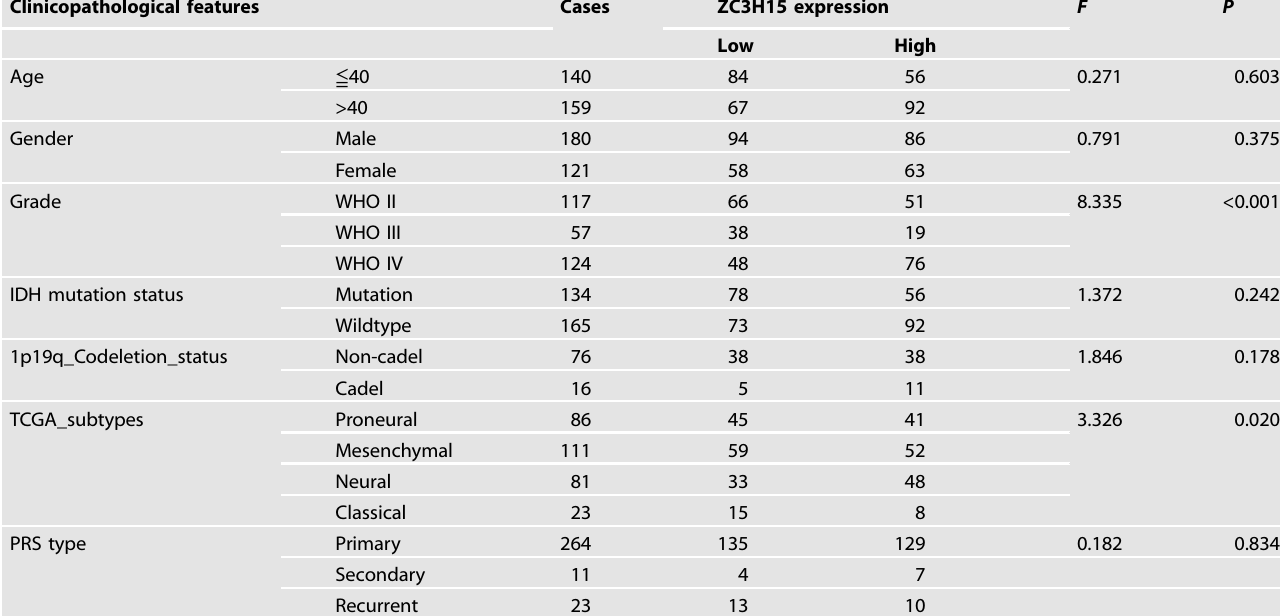
Table 2. Correlation of ZC3H15 expression with clinicopathological variables in CGGA data sets. Clinicopathological